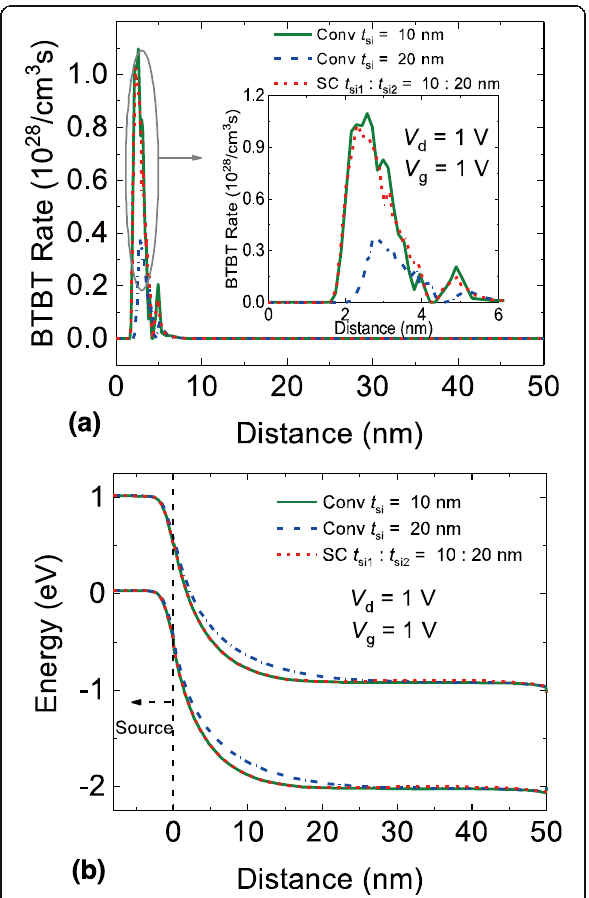
Fig. 2 a BTBT rates and b energy band diagram of the SC TFET and the conventional DG TFETs in the on-state, distance is the lateral position of the cutline AA ’ in Fig.